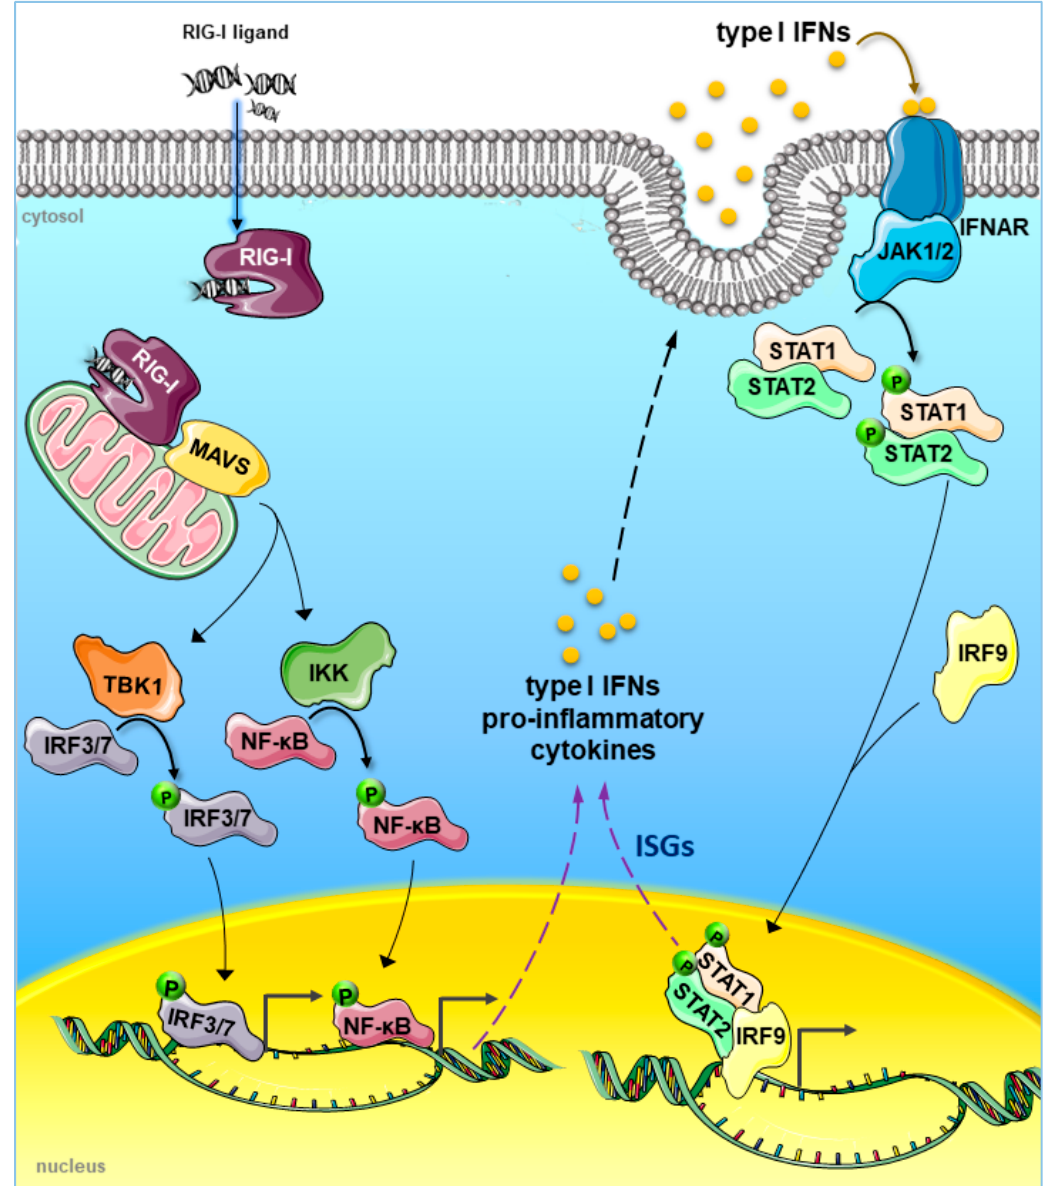
Figure 1. RNA ligand recognition and signal activation by retinoic acid-induced gene-I (RIG-I) sensor. Following the interaction with the ligand, RIG-I can bind to the MAVS adapter protein, anchored in the mitochondrial membrane, which recruits signalling adaptors and kinases, including the IKK family of kinases and TBK1. The signal proceeds from the activated kinases to IRF3, IRF7 and NF- κ B that are in turn activated and translocated into the nucleus where they coordinate the induction of type I IFNs and proinflammatory cytokines. The binding of type I IFNs to their cognate receptor (IFNAR) leads to the transcriptional activation of ISGs by binding of ISGF3 complex containing signal transducer and activator of transcription (STAT)1, STAT2, and IRF9 to IFN-stimulated response elements (ISRE) in the promoters of ISGs. Such an ISG activation induces an amplification of the IFN-inducible feed-forward signalling axis. RIG-I, retinoic acid induced gene 1; MAVS, mitochondrial antiviral-signalling protein; IKK (or I κ B kinase), inhibitor of nuclear factor kappa B; TBK, TANK-binding kinase 1; IRF, interferon regulatory factor; NF- κ B, nuclear factor kappa-light-chain-enhancer of activated B cells; IFNAR, type I interferon receptor; IFN, interferon; ISGs, IFN-stimulated genes; STAT, signal transducer and activator of transcription.